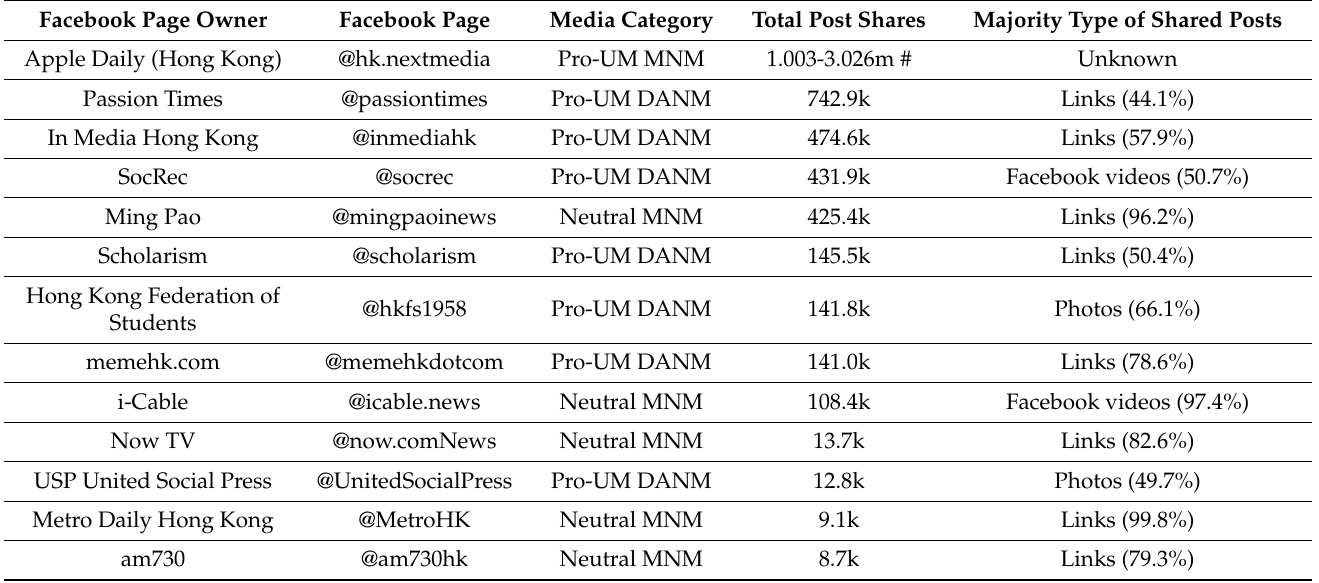
Table 2. Share counts of Facebook posts during the UM (28 September and 15 December 2014)